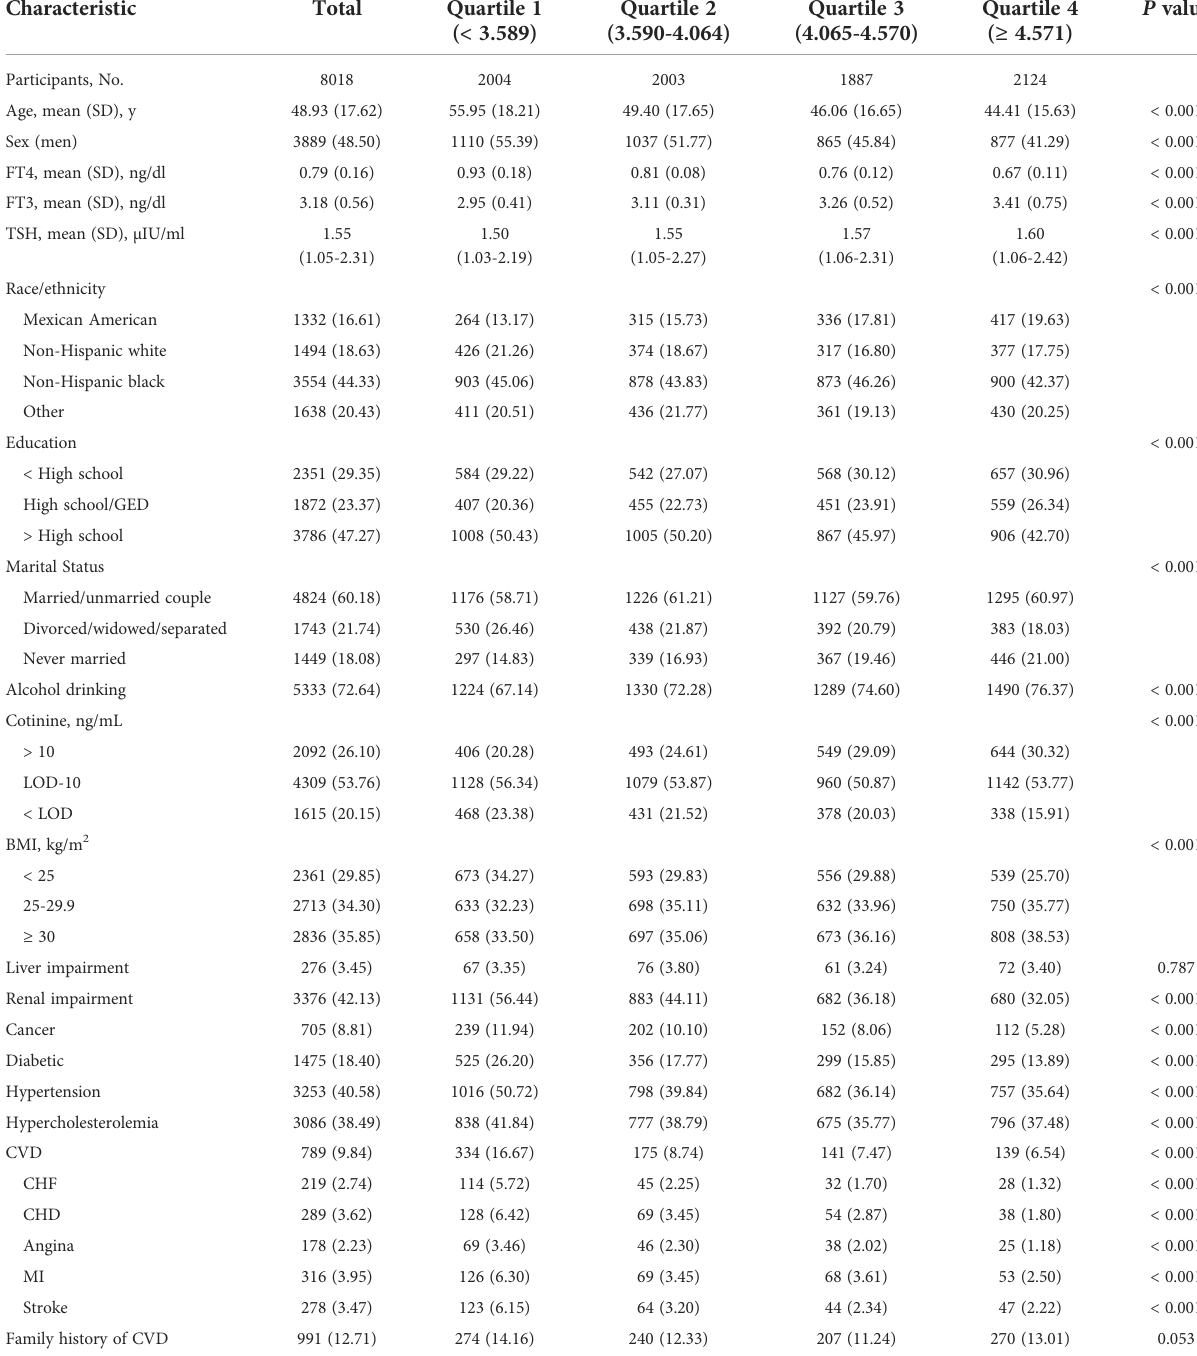
TABLE 1 Baseline characteristics of participants according to the FT3/FT4 ratio in NHANES III (2007-2012).